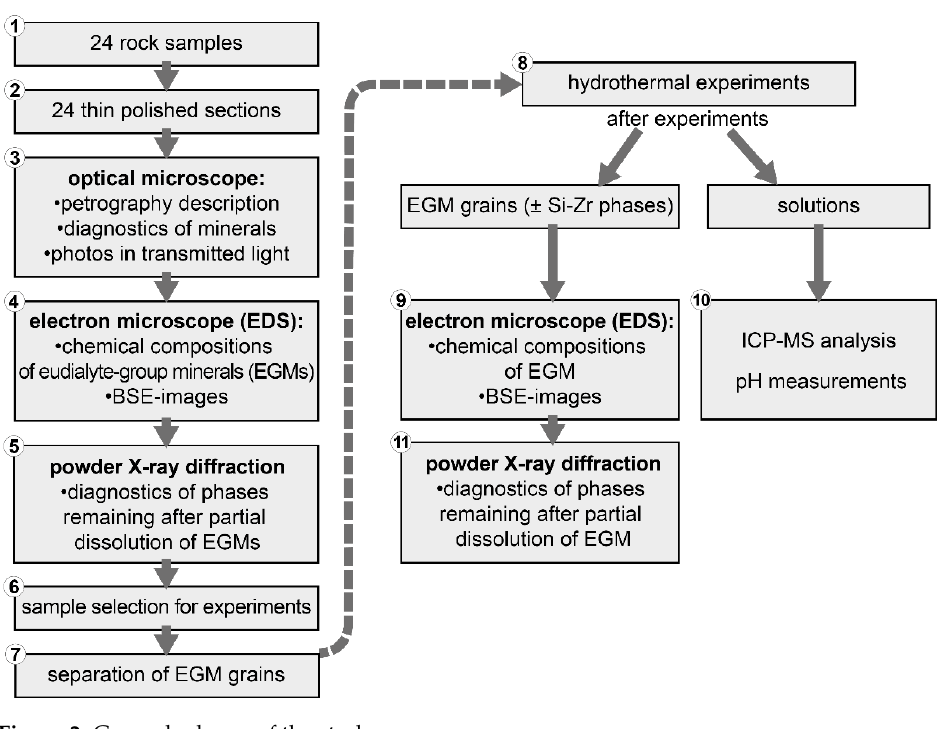
Figure 2. General scheme of the study.